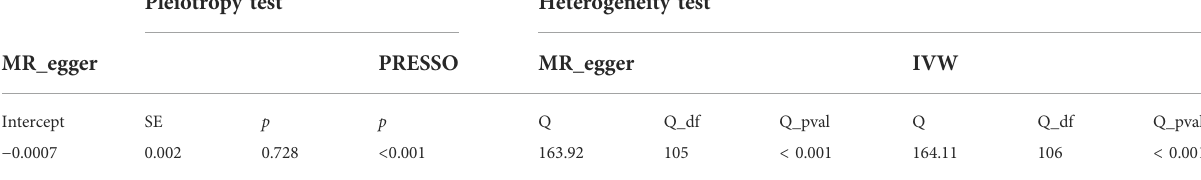
TABLE 1 Sensitivity analysis of serum 25(OH)D genetic IVs in GWAS for low back pain. Pleiotropy